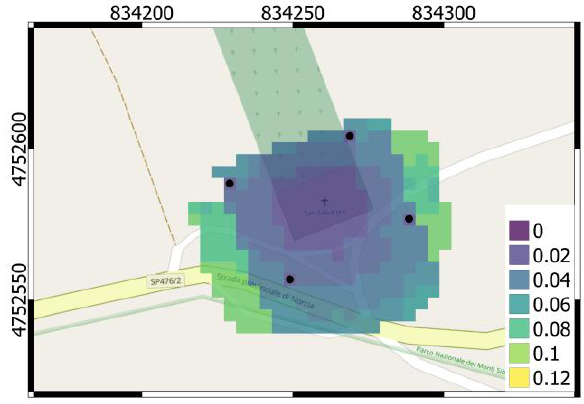
Figure 13. Estimated precisions [m] along Z axis. Concerning the post-processing carried out with MAGO, Figure 14Figure 8 shows the image used for the orthophoto reconstruction (the red rectangle highlights the portion depicted in the orthophoto), whereas Figure 15 reports the resulting orthophoto.